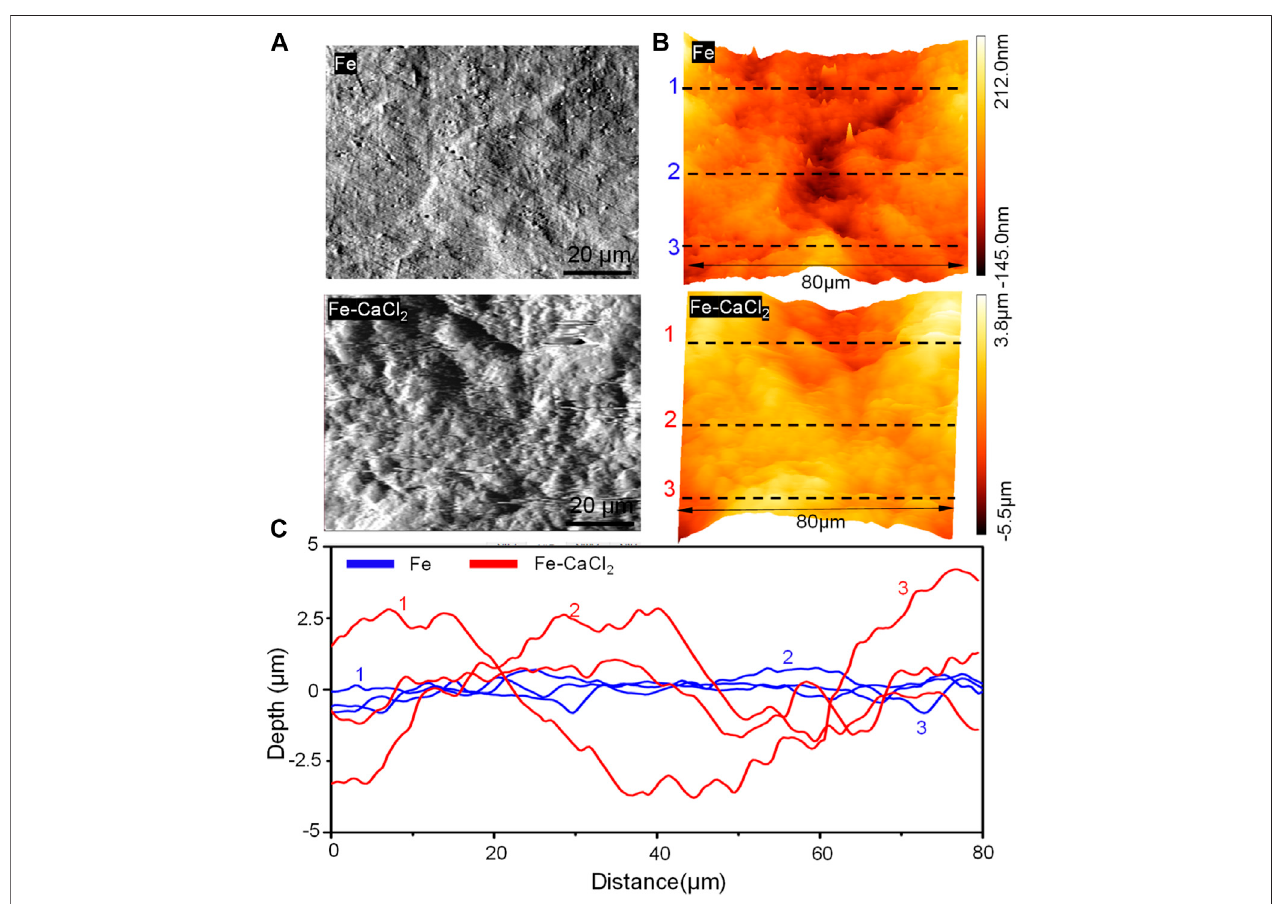
FIGURE 5 | (A) The AFM topography of the part surface in SBF for 28 days at 37 ° C, (B) AFM three-dimensional images, and (C) the derived surface roughness pro fi les.